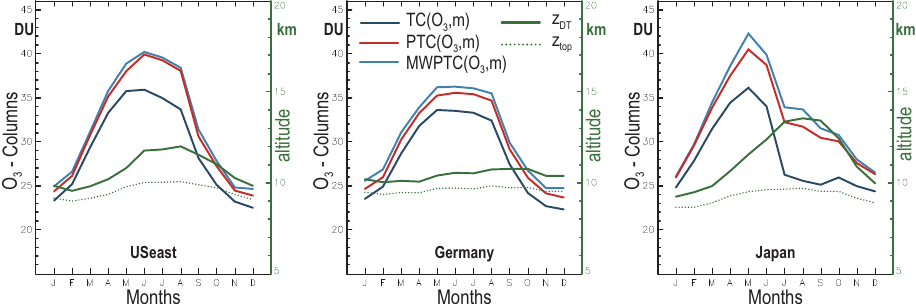
Fig. 4. Validation and impact of 1 on the pure tropospheric columns based on USeast, Germany and Japan seasonal cycles by compar- ing the following: TC ( O 3 ,m) , exactly what MOZAIC has measured in the troposphere (dark-blue line); PTC ( O 3 ,m) , the MOZAIC pure tropospheric ozone column (red line); and MWPTC ( O 3 ,m) , the composite MOZAIC-WOUDC tropospheric ozone column (blue line). All columns are expressed in DU. 1 is located between the altitude (in kilometres, right green vertical axis) given by the solid green line, the monthly average of z DT in all cases, and the dotted green line, the monthly average of z DT if z DT < z top and z top if z DT > z top .